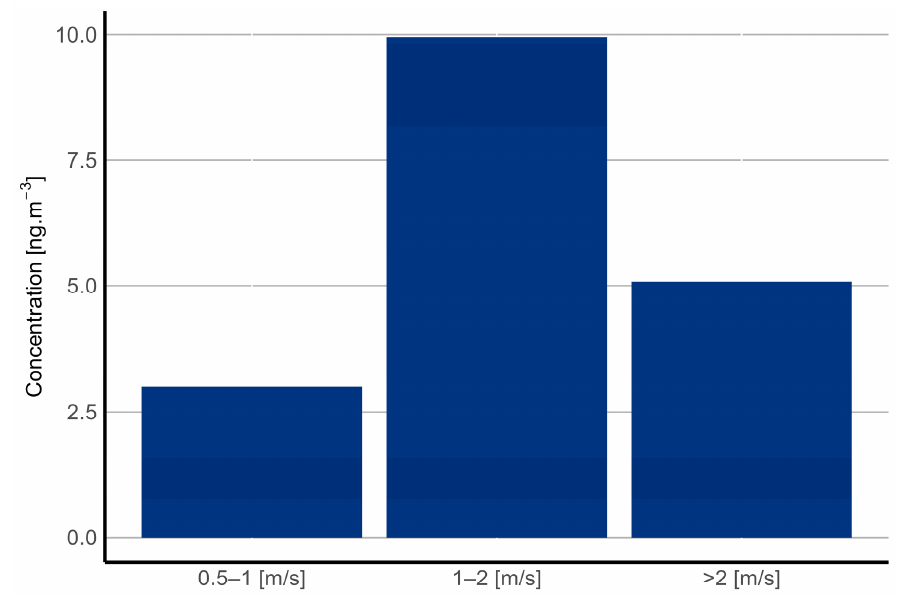
Figure 18. Average BaP concentrations by wind speed categories, V ěřň ovice station, 2020.